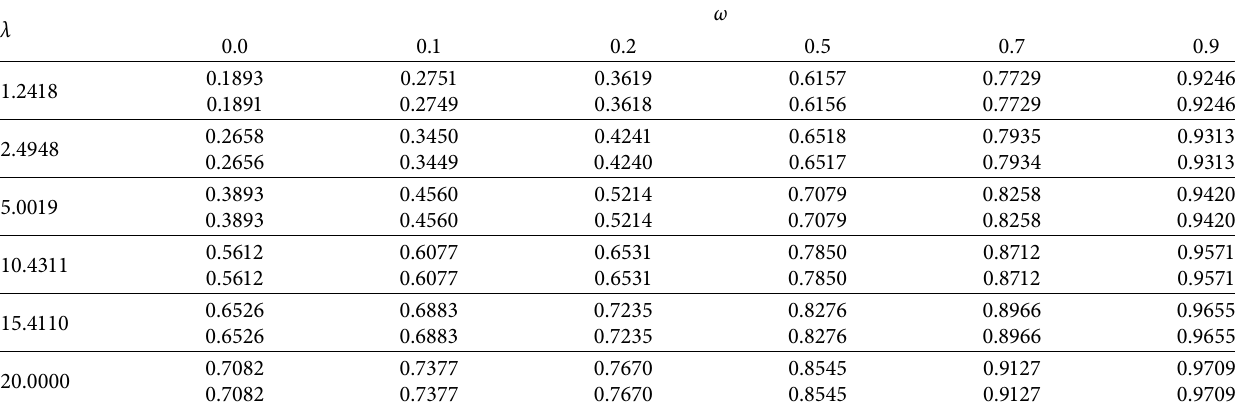
Table 4: Values of risk ratios R and λ � ‖ ] ‖ 2